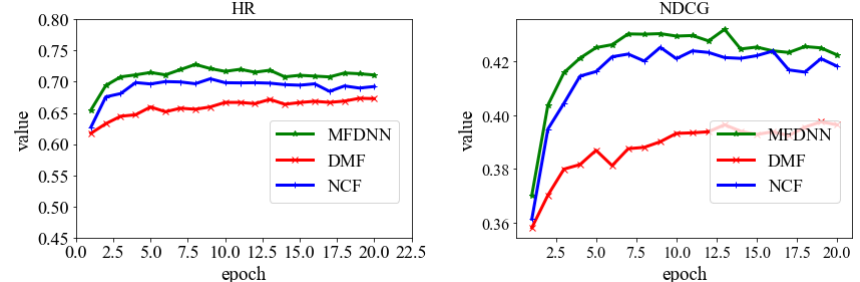
Figure 13. The HR and NDCG values for the MFDNN and baseline